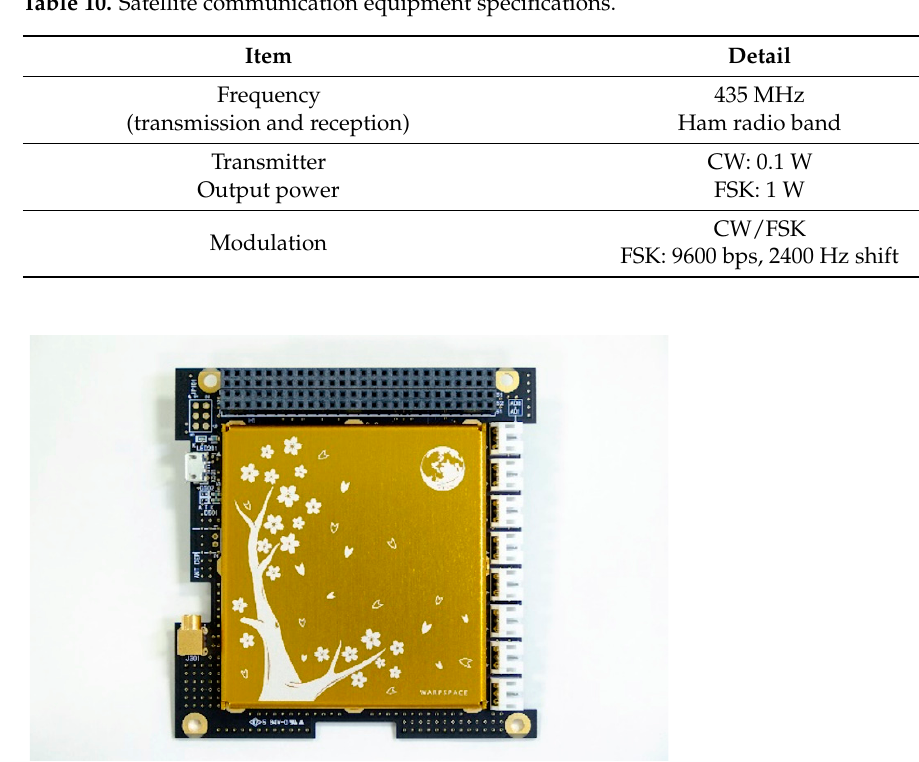
Figure 14. Communication component for CubeSat installation. Table 10. Satellite communication equipment specifications.